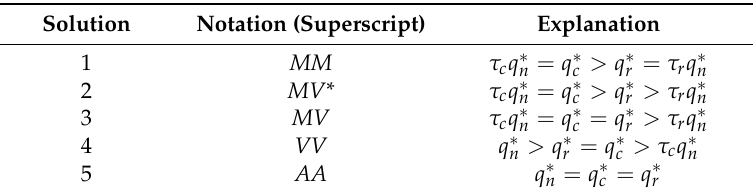
Table 2. Solutions and explanation.